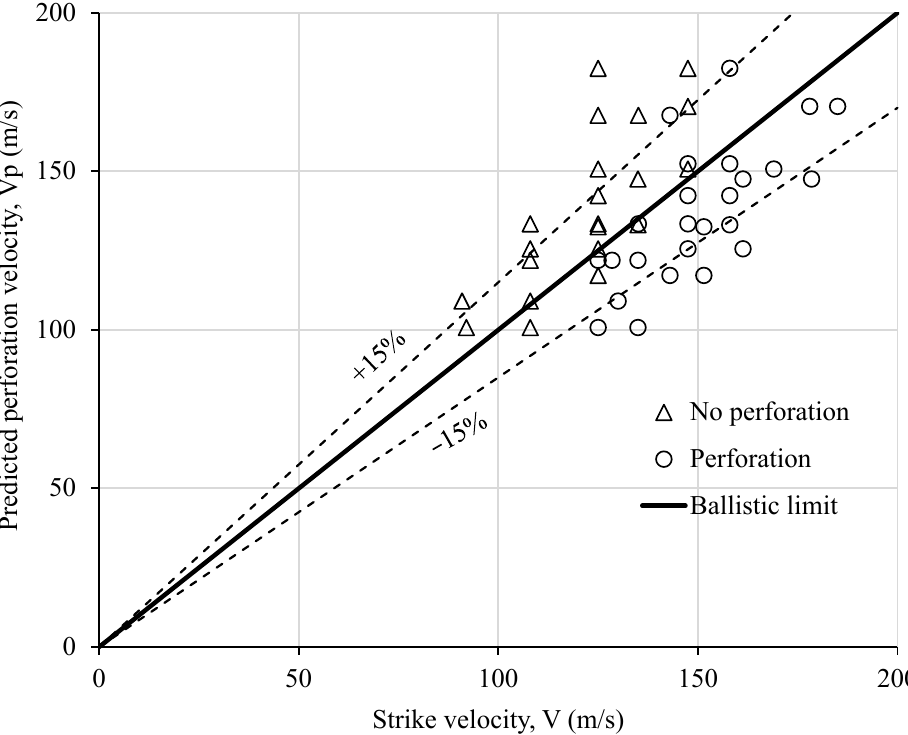
Figure 12. Ballistic limit prediction based on quasi-static punching energy.